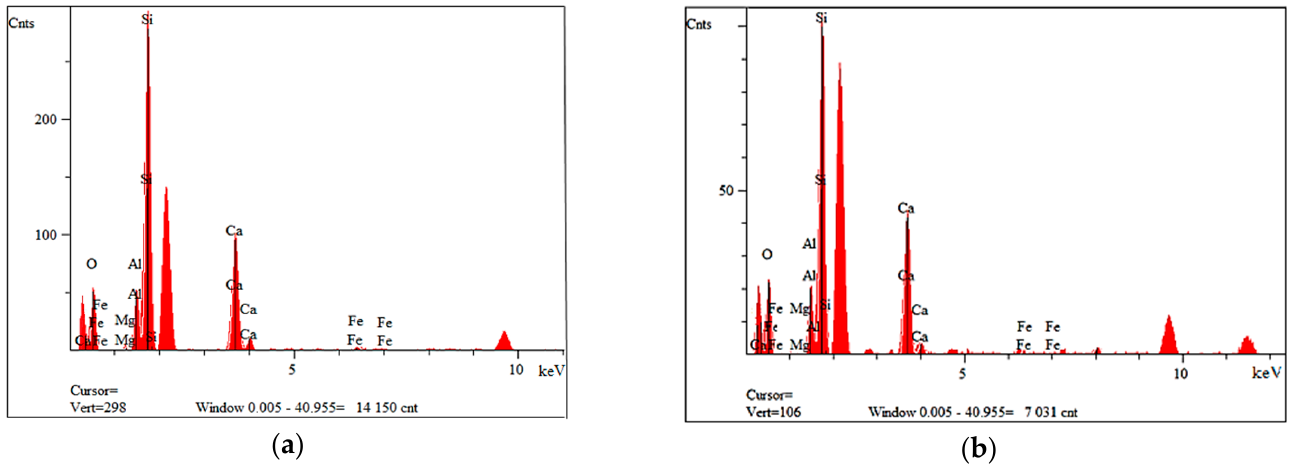
Figure 4. EDS analysis of fraction I from wind turbines: ( a ) for point 2 of Figure 3b; ( b ) for point 3 of Figure 3b.